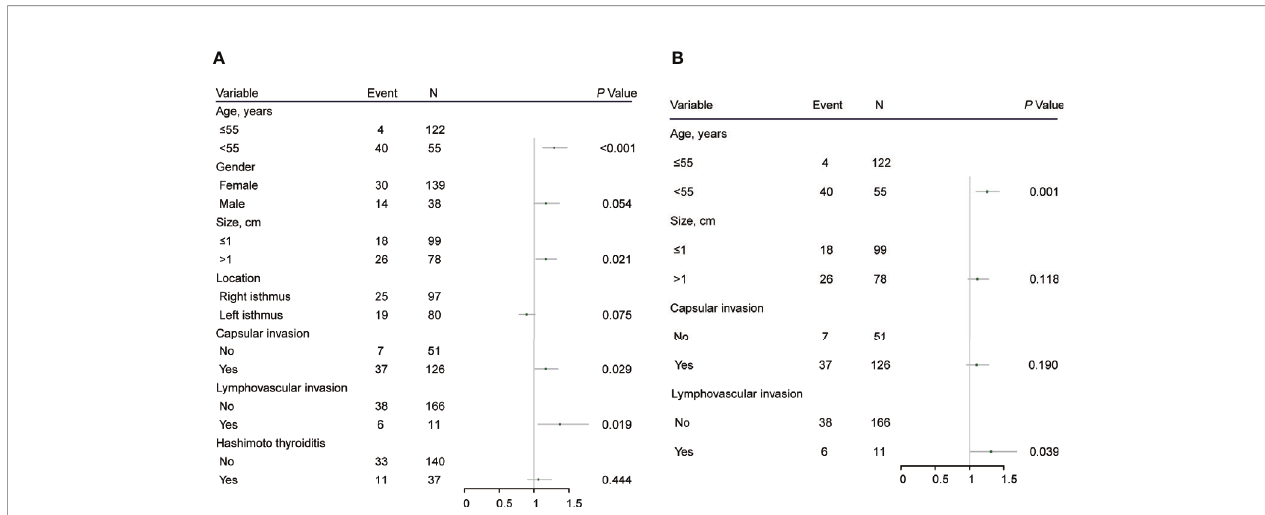
FIGURE 5 | (A) Univariate logistic regression analysis of clinicopathological factors associated with contralateral CLN metastasis for patients underwent thyroidectomy with BCLND. (B) Multivariate logistic regression analysis of clinicopathological factors associated with contralateral CLN metastasis for patients underwent thyroidectomy with BCLND.